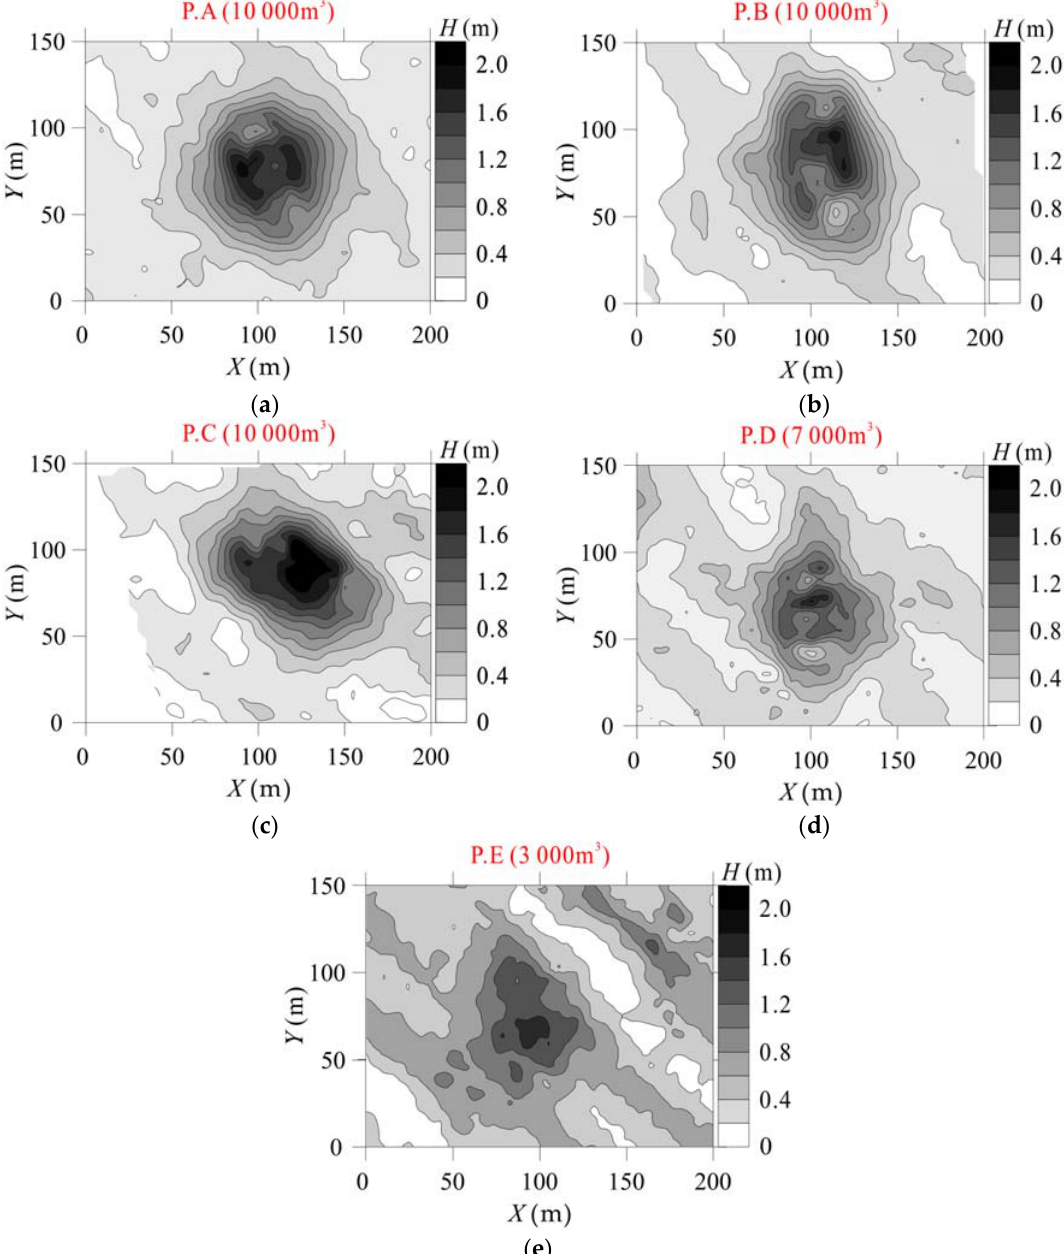
Figure 10. Morphology of sediment mounds after dumping at five positions: ( a ) P.A ( b ) P.B ( c ) P.C ( d ) P.D ( e ) ( d ) P.D ( e ) P.E.